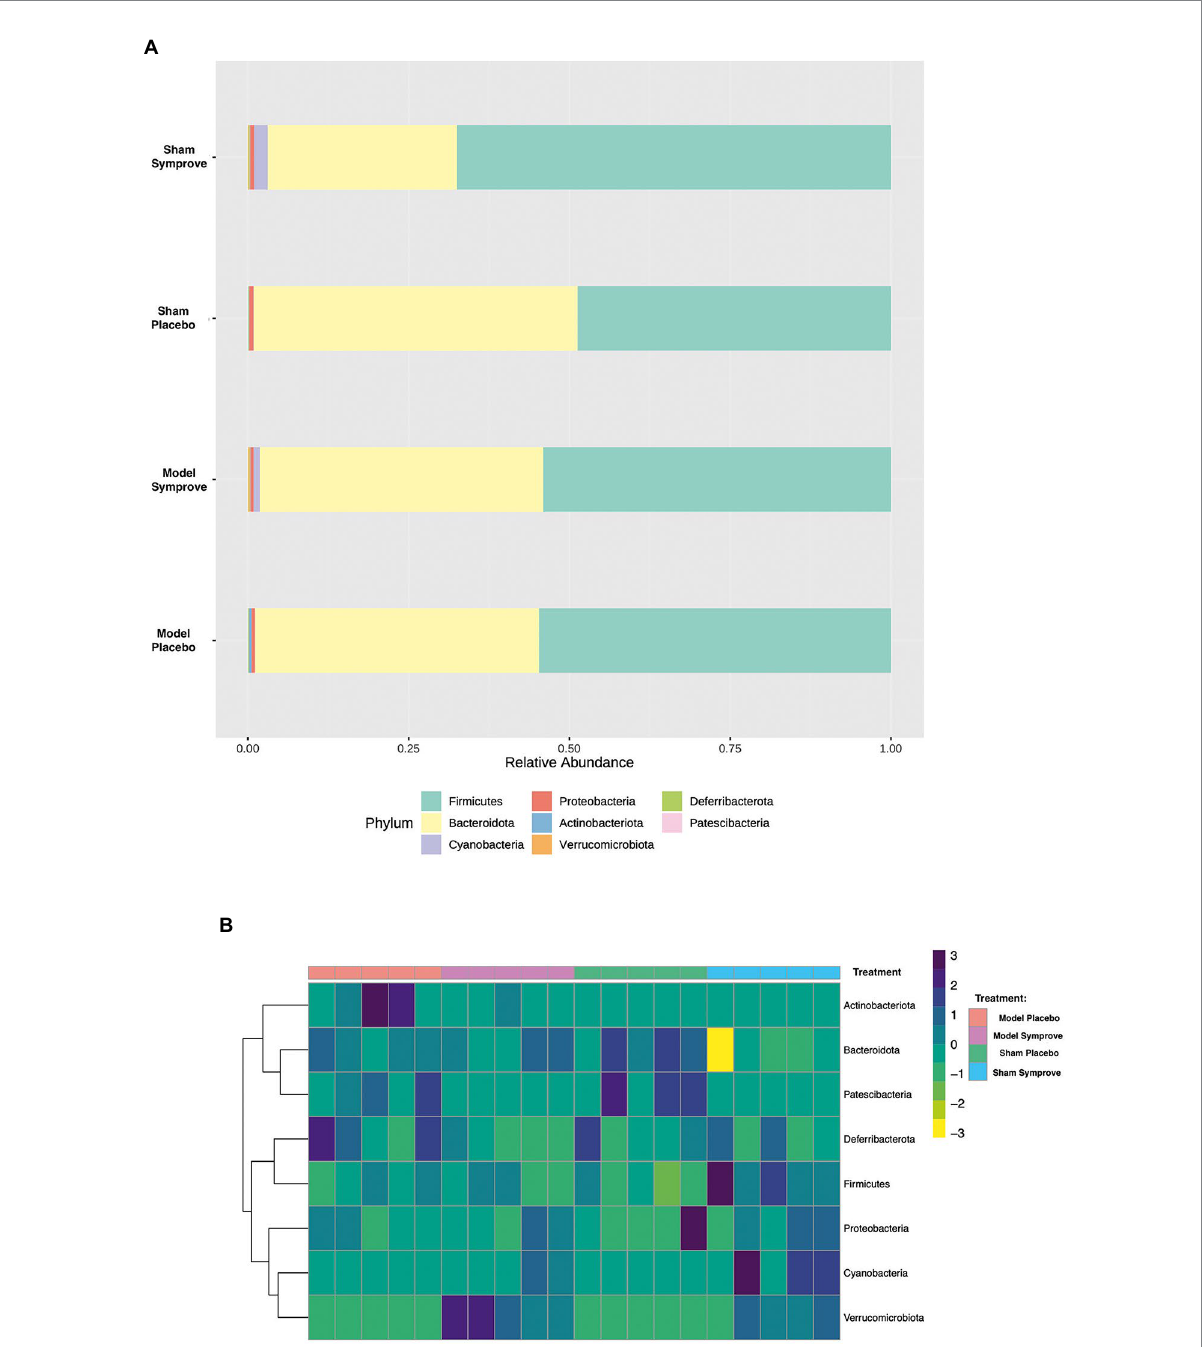
FIGURE 7 Effect of Symprove ™ treatment on bacterial load and the relative abundance at phylum level in all experimental groups. (A) Data are shown as relative abundance of the means of a subset of n = 5 animals/group; only in the sham group, Symprove ™ was able to significantly increase Bacteroidetes. (B) Heatmap of most counted operational taxonomic units (OTUs; relative abundance >0.5%) for each sample in the